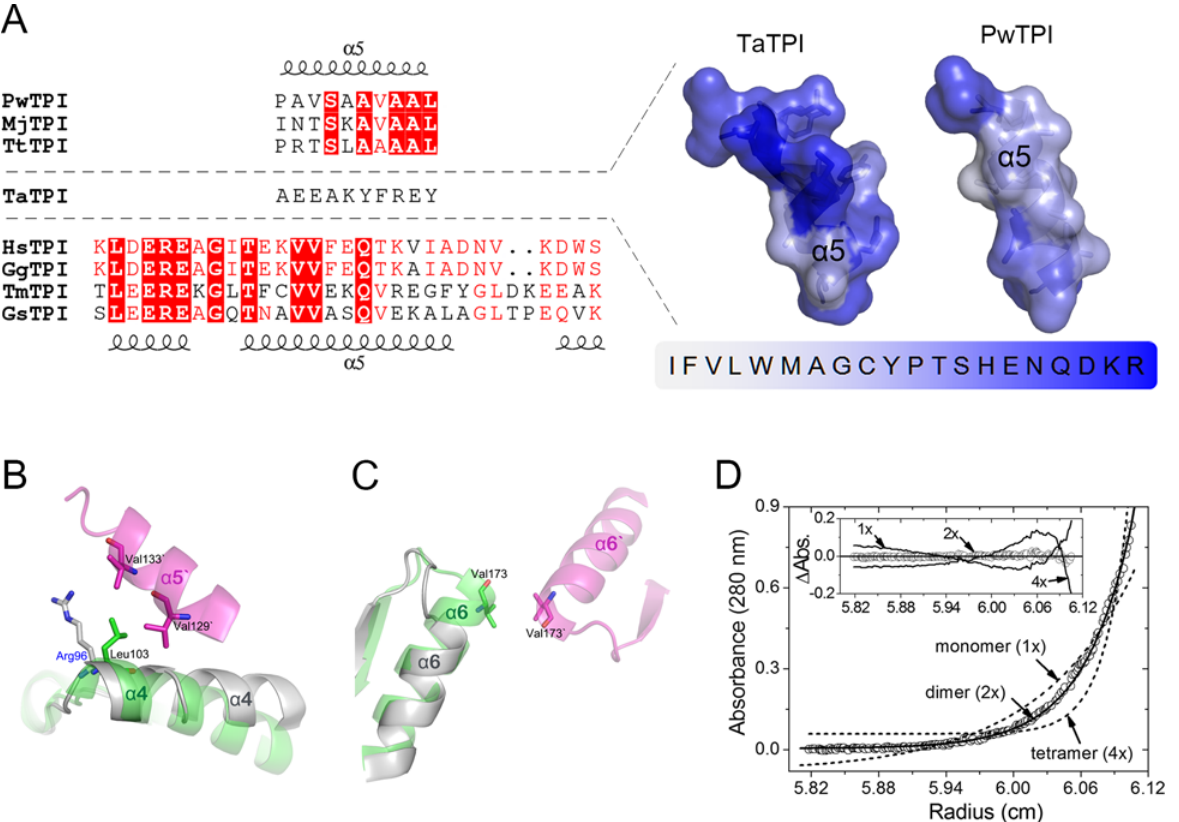
Fig 2. Dimeric conformation of TaTPI. (A) Structure-based sequence alignment of helix 5 region among TPIs from Thermoplasma acidophilum (TaTPI), Pyrococcus woesei (PwTPI), Methanocaldococcus jannaschii (MjTPI), Thermoproteus tenax (TtTPI), Homo sapiens (HsTPI), Gallus gallus (GgTPI), Thermotoga maritima (TmTPI), and Geobacillus stearothermophilus (GsTPI). Strictly conserved amino acid residues are highlighted in red shaded boxes and moderately conserved amino acid residues are colored in red. Helix 5 regions of TPIs from Thermoplasma acidophilum (PDB ID: 5CSR) and Pyrococcus woesei (PDB ID: 1HG3) are shown as cartoon representation with transparent surfaces, where amino acid residues are colored according to normalized consensus hydrophobicity scale [31]. (B) and (C) Structural comparison of helix 4 and helix 6 in TaTPI (gray) and PwTPI (green and magenta, each from different monomers). The important amino acid residues in tetrameric interface are shown as stick model. (D) Analytical ultracentrifugation experiment of TaTPI. Sedimentation equilibrium distribution (circle) of TaTPI at 26,000 rpm and 20°C is plotted as circle. Concentration of TaTPI was 16.8 u M (0.41 mg ml -1 ) in 20 m M Tris-HCl, pH 7.5, and 0.2 M NaCl. Solid line is a fitting line for a homogeneous dimer (2x) model and dotted lines are fitting lines for homogeneous monomer (1x) and tetramer (4x) models. Calculated molecular weight for TaTPI monomer from its amino acid compositions is 24,671 daltons. Inset graph shows distributions of the residuals for homogeneous 1x, 4x (solid lines), and 2x (circle) models, respectively. The random distribution of the residuals for the 2x model indicates that TaTPI exists as homogeneous dimers in solution.